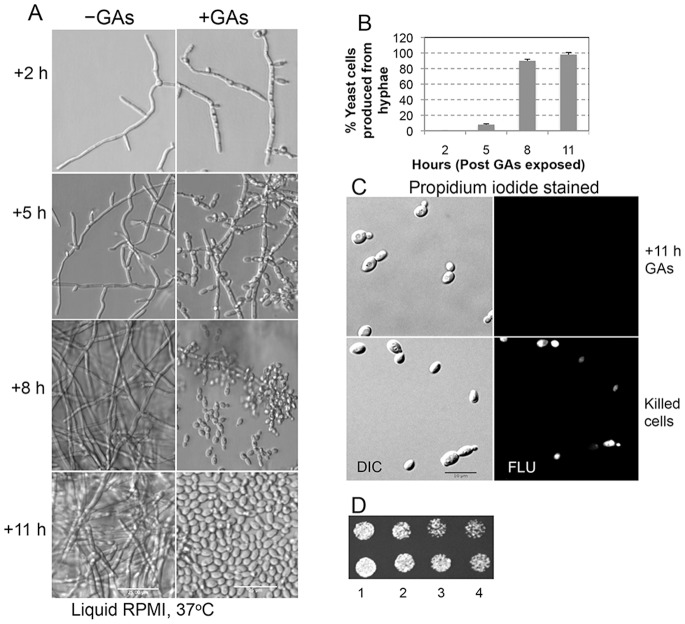
GAs-mediated conversion of C. albicans hyphae into yeast cells.(A) Four hours old hyphae of C. albicans were incubated in hyphal growth promoting medium (RPMI) at 37°C with or without GAs in microtiter wells under static condition. At the indicated post incubation time intervals (+2, +5, +8 and +11 h), conversion of hyphae into yeasts was monitored using an inverted microscope. Scale bars = 25 µm. (B) Percentage of released yeast cells from hyphae due to GAs exposure, at least from 3 different wells, were counted at each time points. Error bars indicate standard deviation. (C) Live/dead assay of yeast cells using propidium iodide (PI) stain was performed with the cells generated from GAs-exposed hyphae. An aliquot of cells from +11 h sample was stained with PI and viewed under fluorescence (FLU) microscope (Zeiss) with red filter. Corresponding DIC images were also recorded. As a positive control, yeast cells were killed by exposing them to 100% ethanol for 5 minutes and washed twice with sterile water to remove ethanol. Cells were stained with PI in parallel with test samples. Scale bar = 10 µm. (D) Viability of cells from 11 h post GAs-treated samples (duplicates) were two fold-serially diluted and 5 µl from each dilution (1 to 4) were spotted on YPD agar plate. Growth of cells was assessed after 16 h incubation at 30°C. Sparse growth of colonies can be seen from the 4th diluted samples.